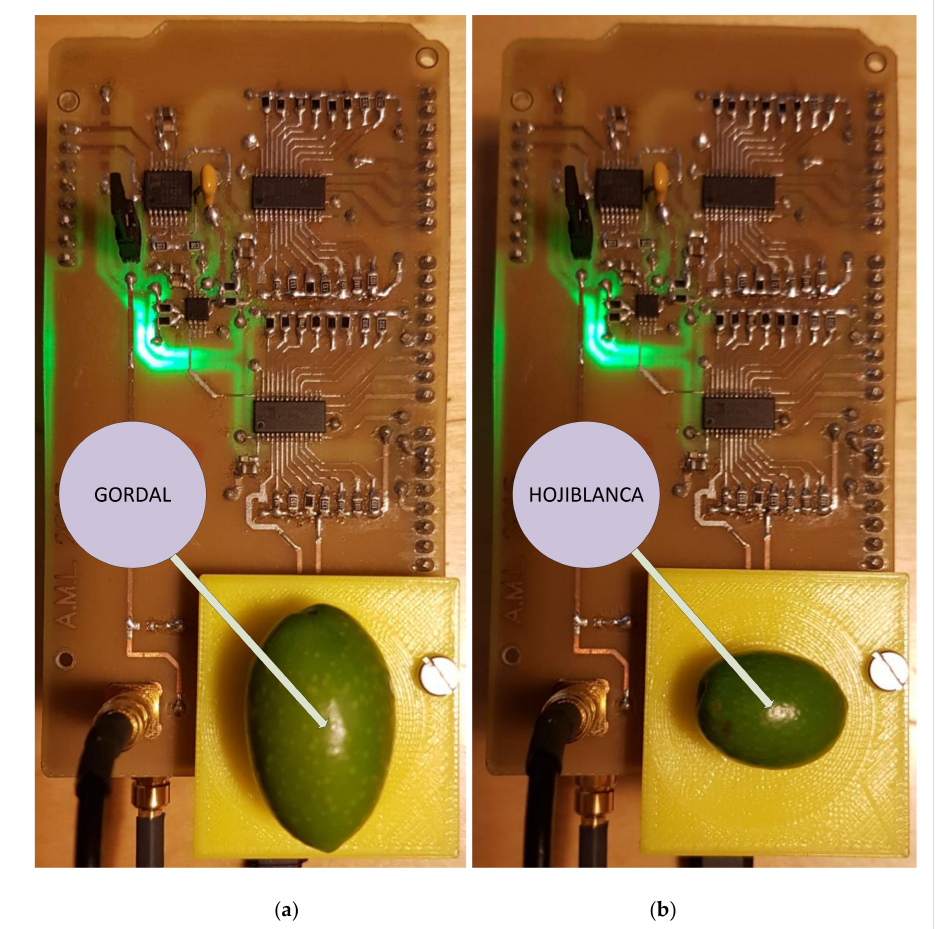
Figure 4. ( a ) “Gordal Sevillana” and ( b ) “Hojiblanca” olive varieties during the electrical impedance